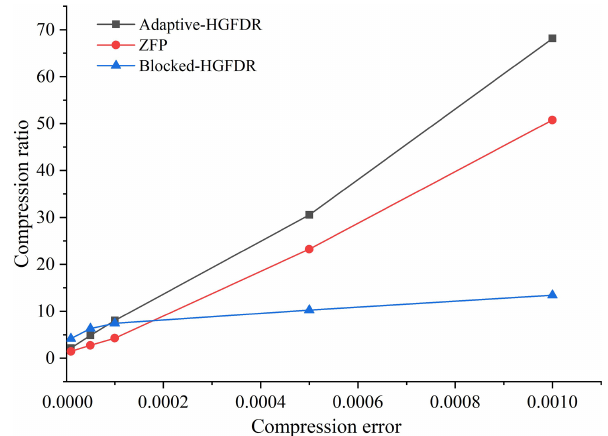
Figure 5. The relationship between the compression error and com- pression ratio for different